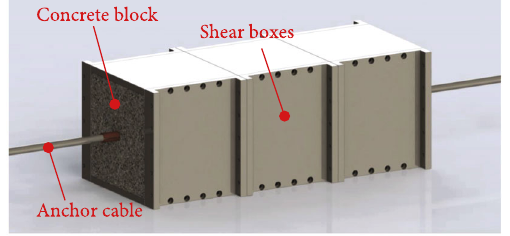
Figure 4: Main test